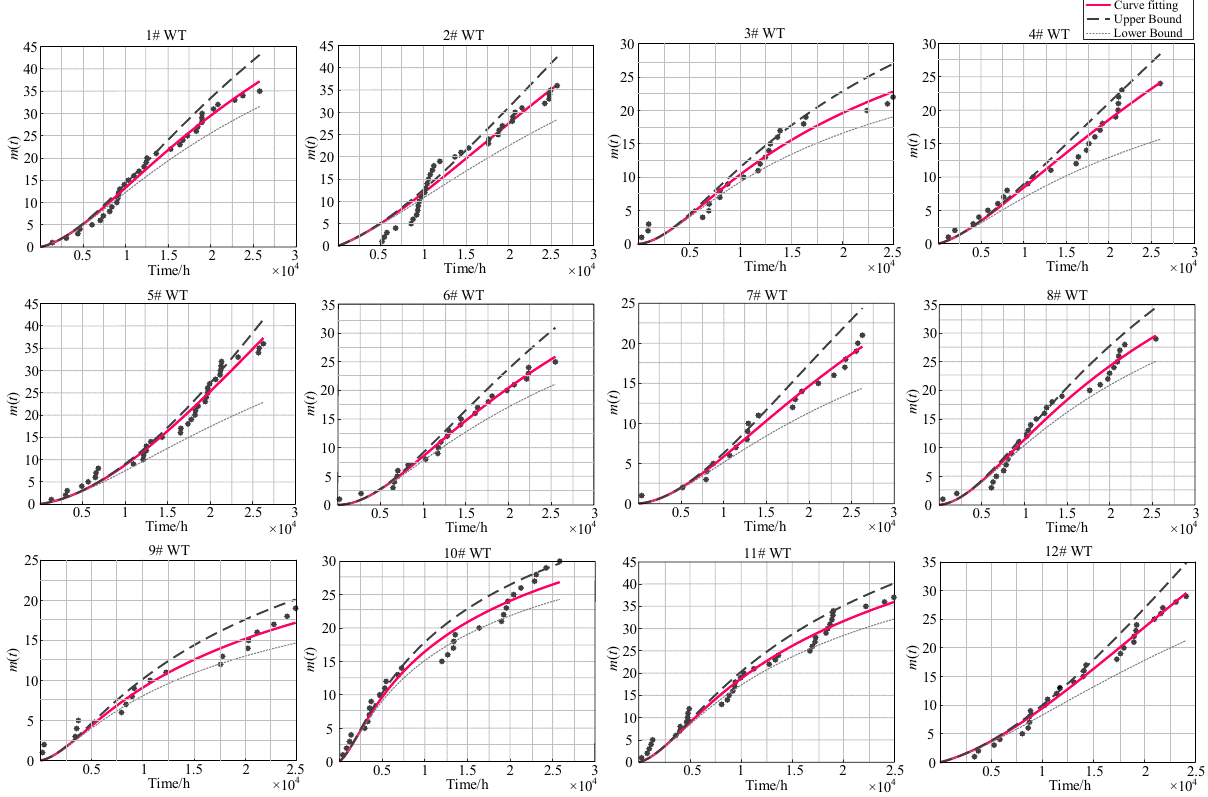
Figure 1. Maximum likelihood estimation fitting curves of the cumulative number of